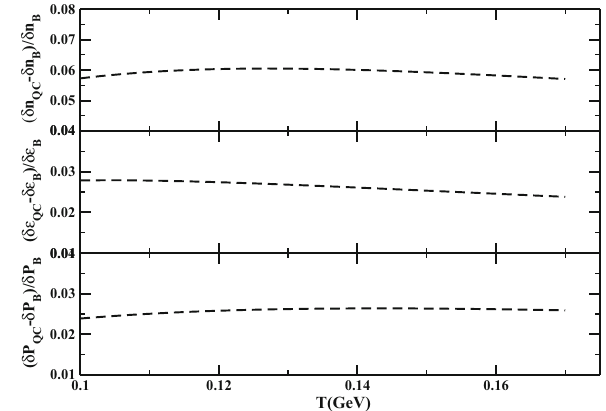
Fig. 2 Relative correction of non-extensive part using BE/FD distri- bution over Boltzmann statistics